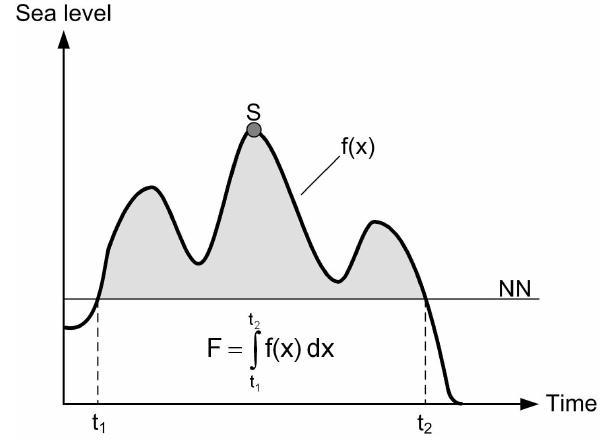
Fig. 13. Definition of the storm surge intensity as considered for the present